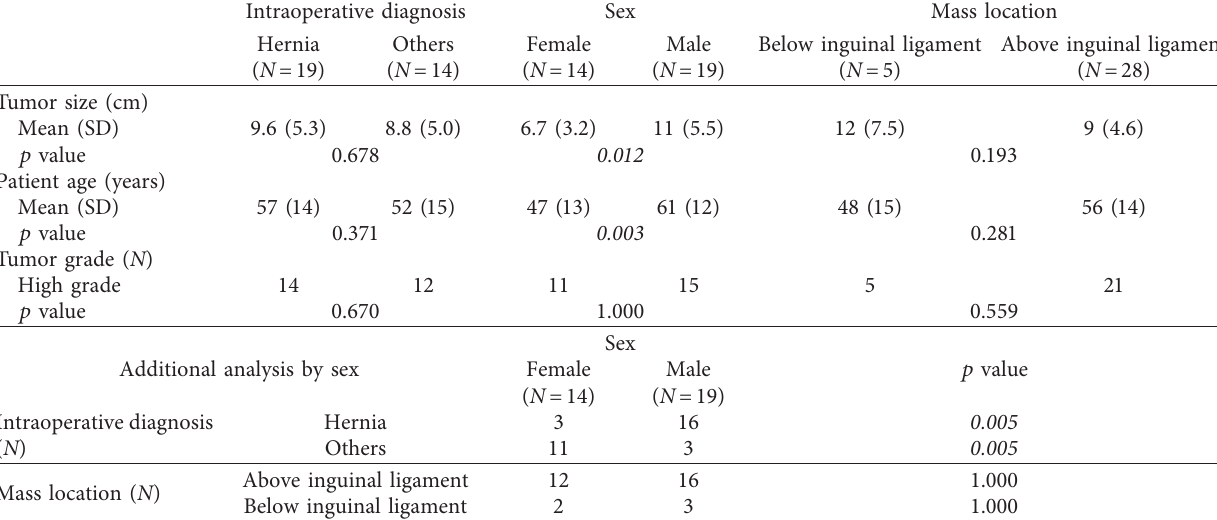
Table 2: Analysis of clinically relevant features.